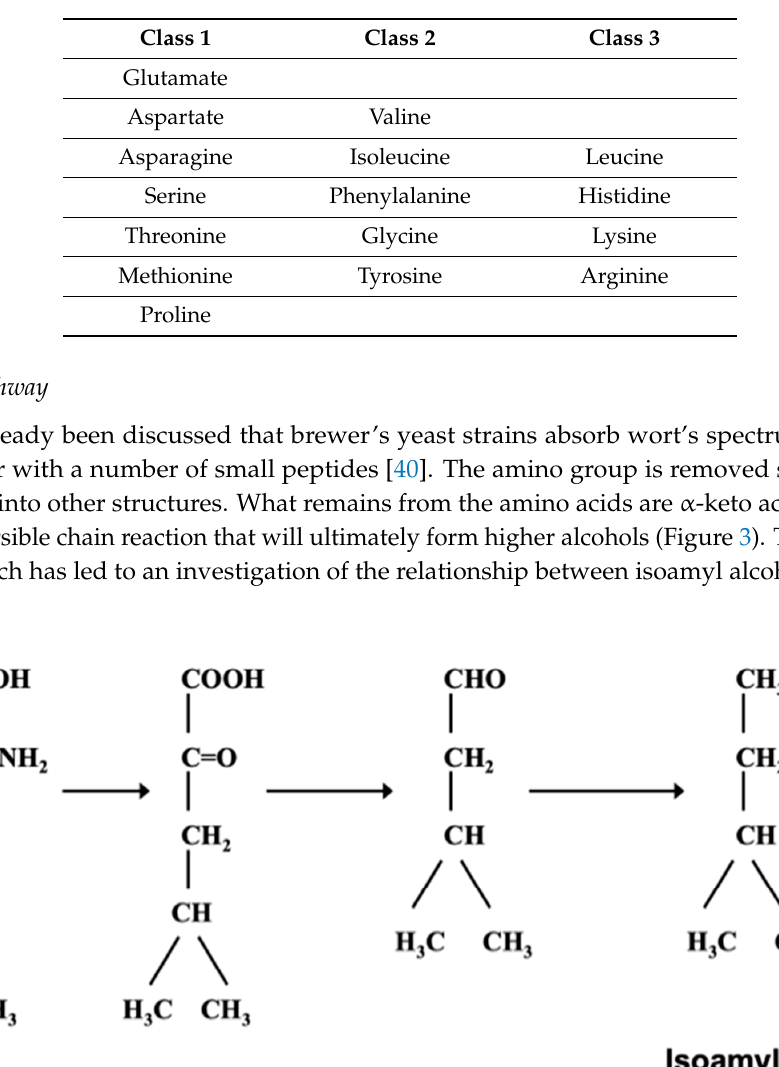
Table 2. Classification of amino acids on the basis of their essential nature. From Pierce (1987) [29].